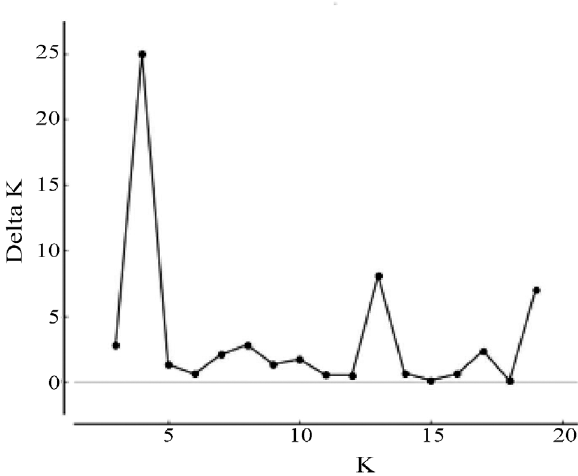
Figure2 -Graphicalrepresentationoftheoptimalnumberofgroupsinthe program Structure inferred using the criterion of Evanno et al. (2005). The analysiswasbasedondataobtainedfrom58microsatellite loci incorecol- lection evaluated for genetic